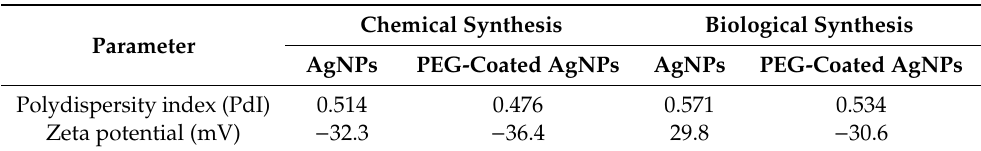
Table 2. The polydispersity index and zeta potential measurements of AgNPs determined using Zetasizer